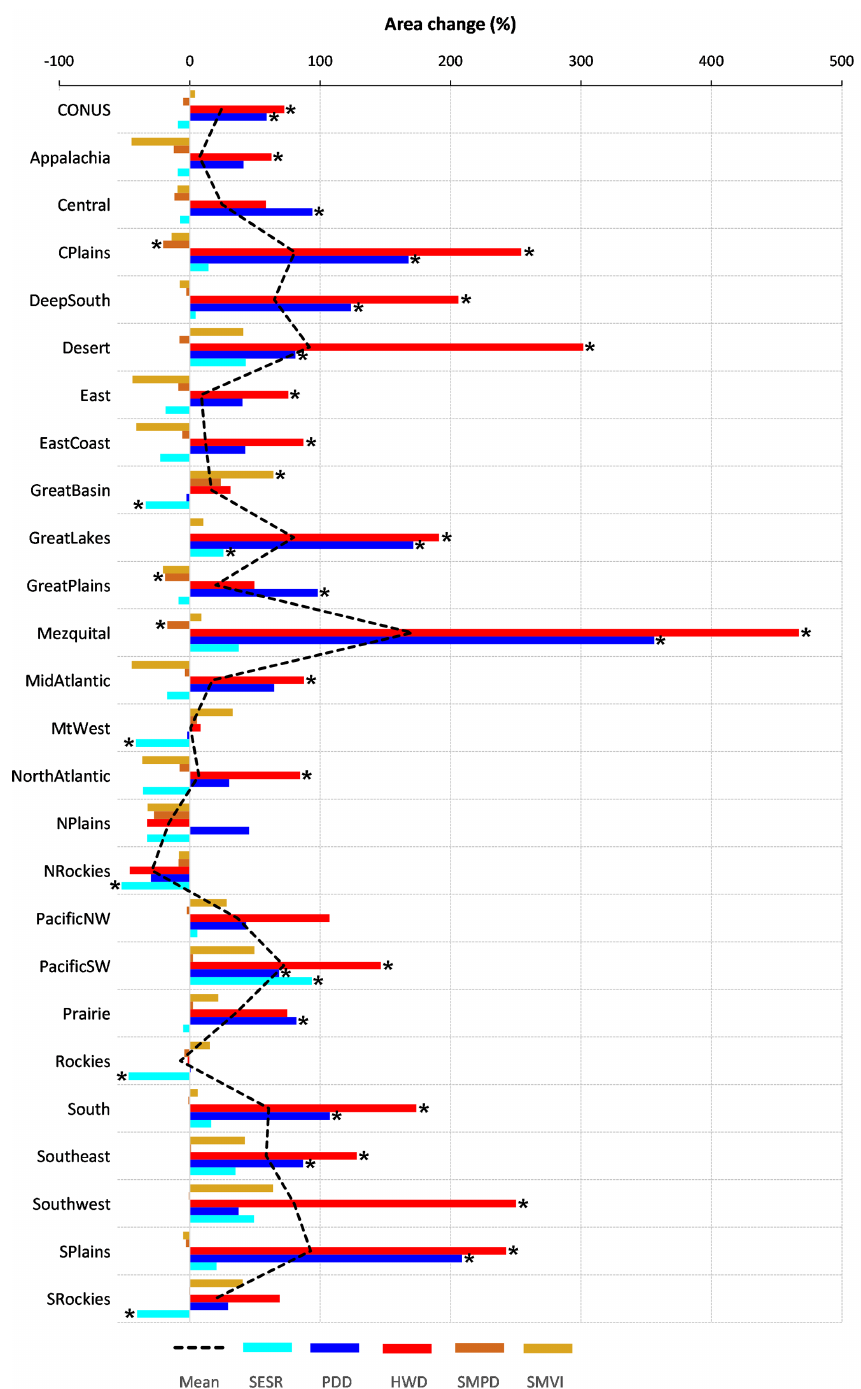
Figure 8. Percentage change in areas hit by flash drought in 2009–2018 compared to 1979–1989 for CONUS and all Bukovsky regions. Dashed black line represents the mean of all definitions per region. Significant trends (according to the Mann–Kendall test) are marked by